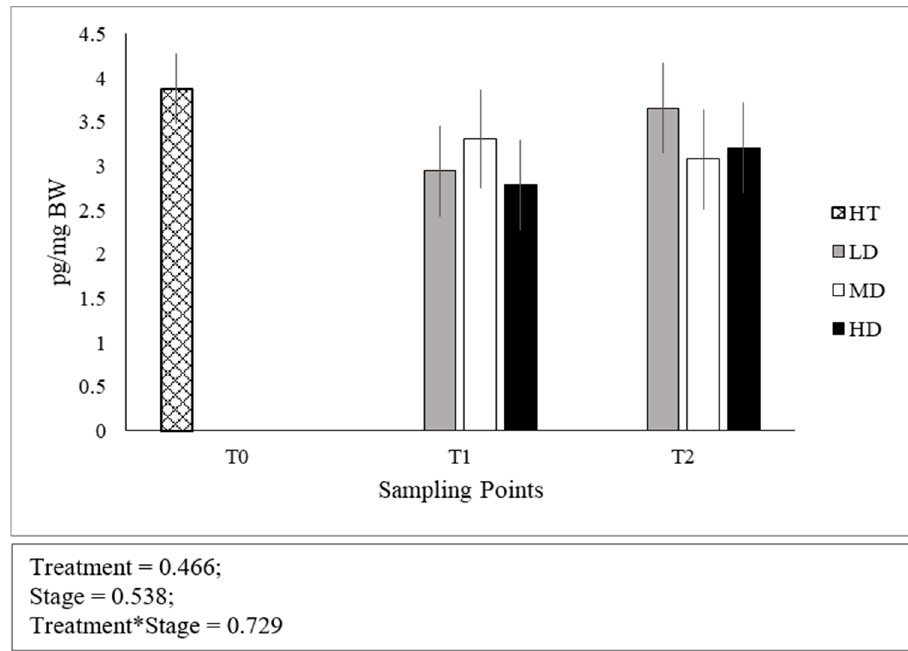
Figure 2. Whole-body cortisol concentrations expressed as pg per mg of body weight. Error bars indicate the standard error of the mean for each treatment/stage of development.